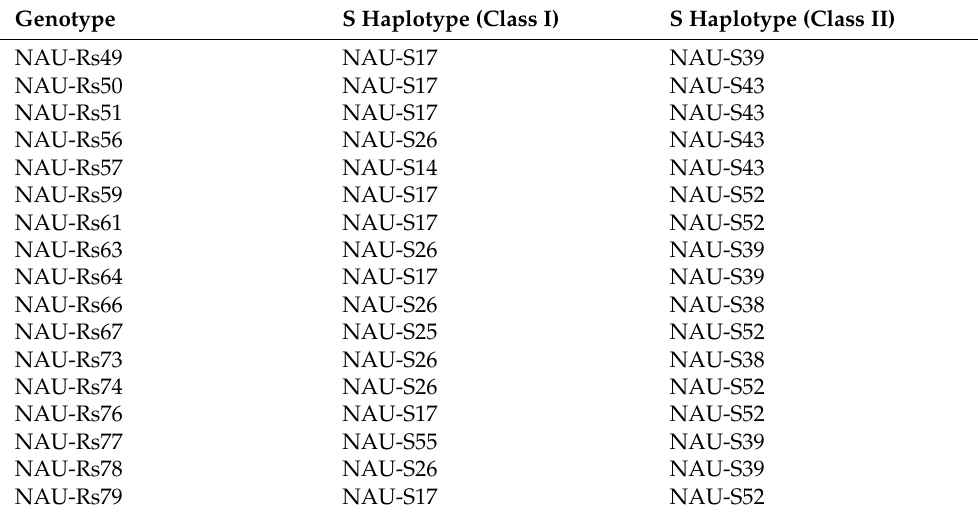
Table 5. Distribution of S haplotype in 17 Class I/II radish